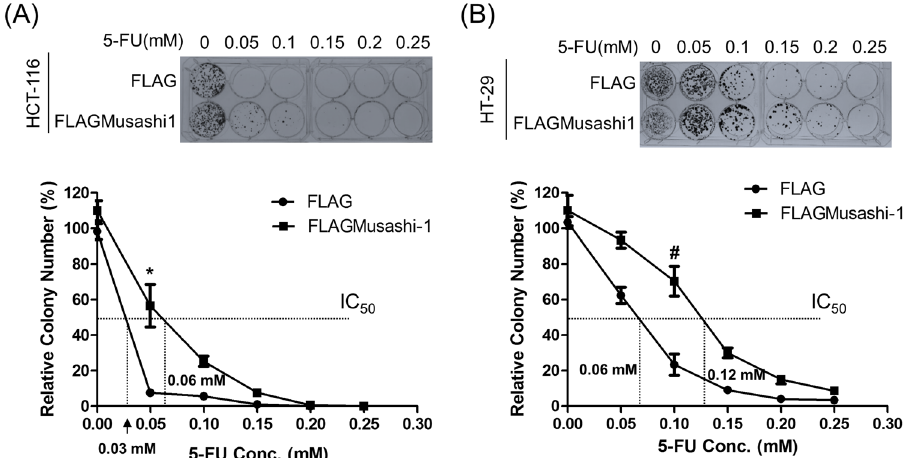
Figure 3. Overexpression of Musashi-1 enhances drug resistance in CRC cells. ( A ) FLAG- or FLAGMusashi- 1-overexpressing HCT-116 were pretreated with increasing concentrations of 5-FU. Cells were then subcultured and seeded into new 6-well culture plates, fixed, and stained. Images were acquired using a Canon digital camera (upper panel). The relative cell survival curves were calculated and normalized. Square and circle indicate the mean ± SD from three independent experiments. * p < 0.01 (lower panel). ( B ) FLAG- or FLAGMusashi-1-overexpressing HT-29 cells were pretreated with increasing concentrations of 5-FU. Cells were then subcultured and seeded into new 6-well culture plates, fixed, and stained. Images were acquired using a Canon digital camera (upper panel). The relative cell survival curves were calculated and normalized. Square and circle indicate the mean ± SD from three independent experiments. # p < 0.05 (lower